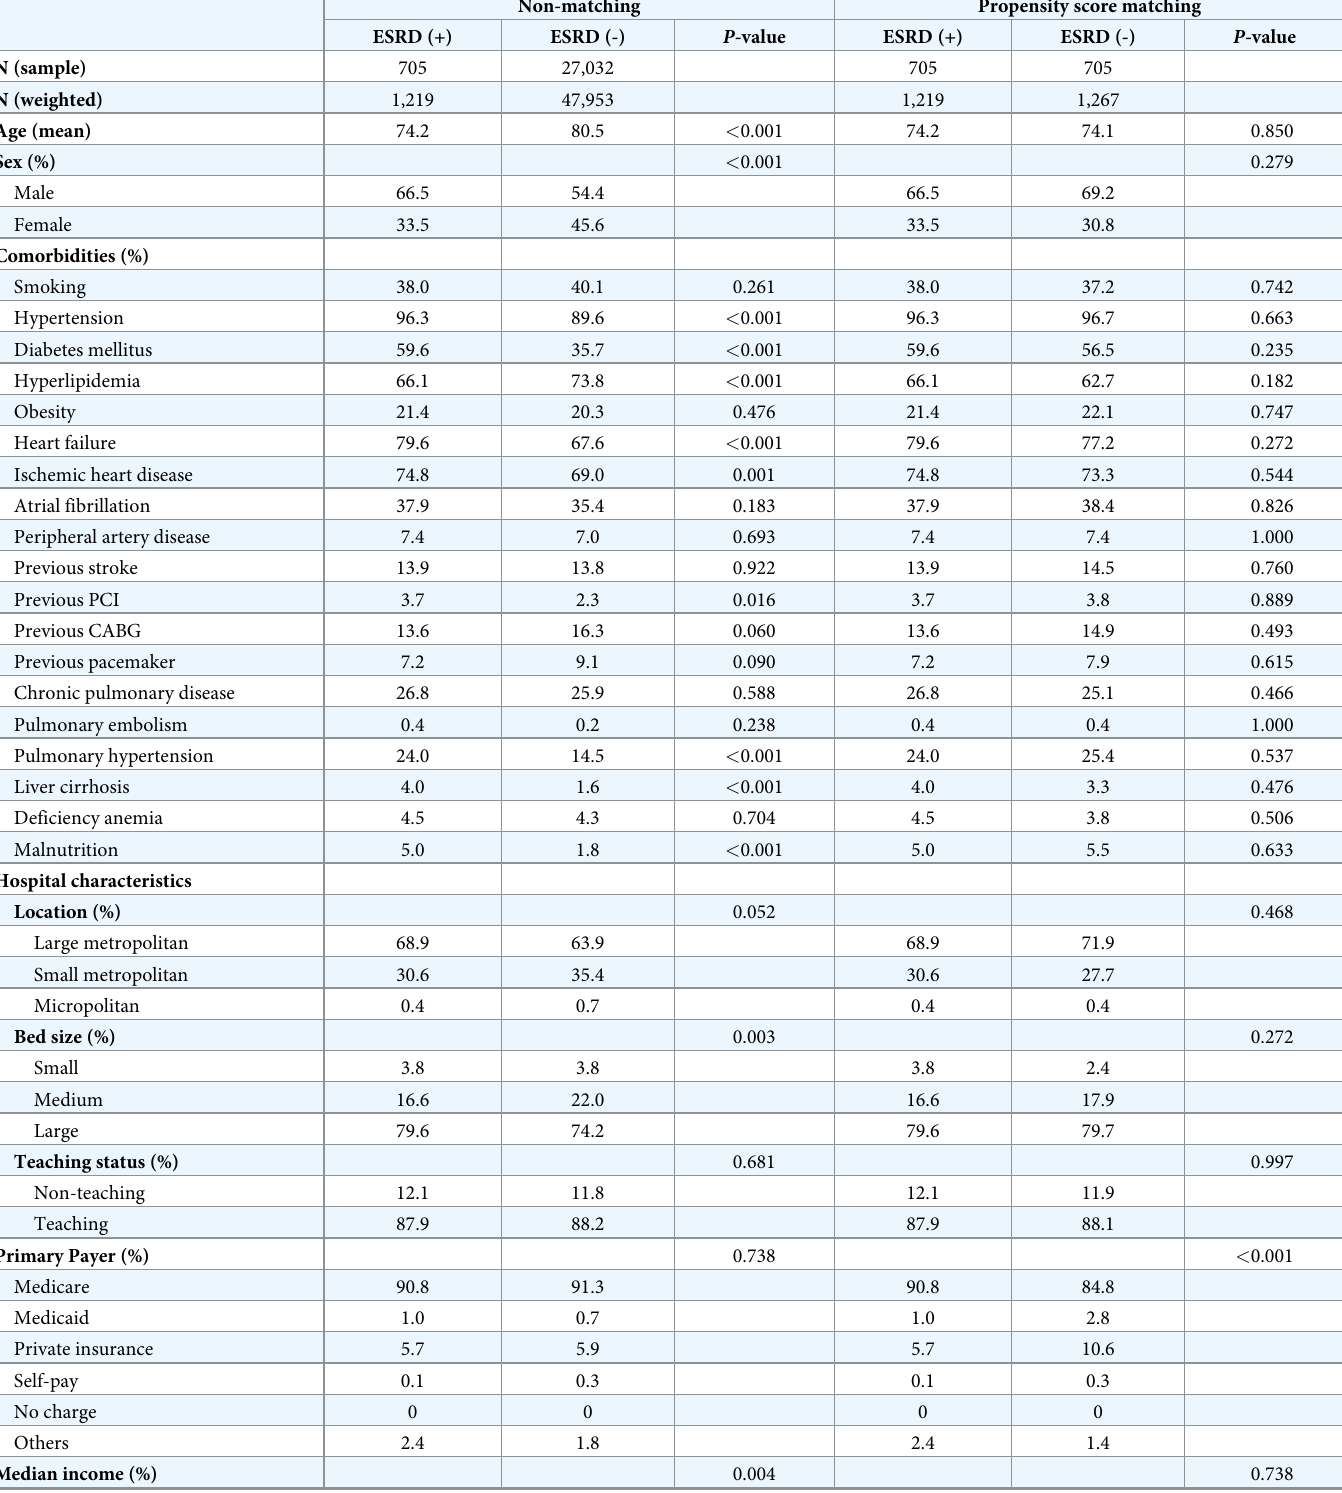
Table 1. General characteristics of index hospitalizations for TAVR with and without